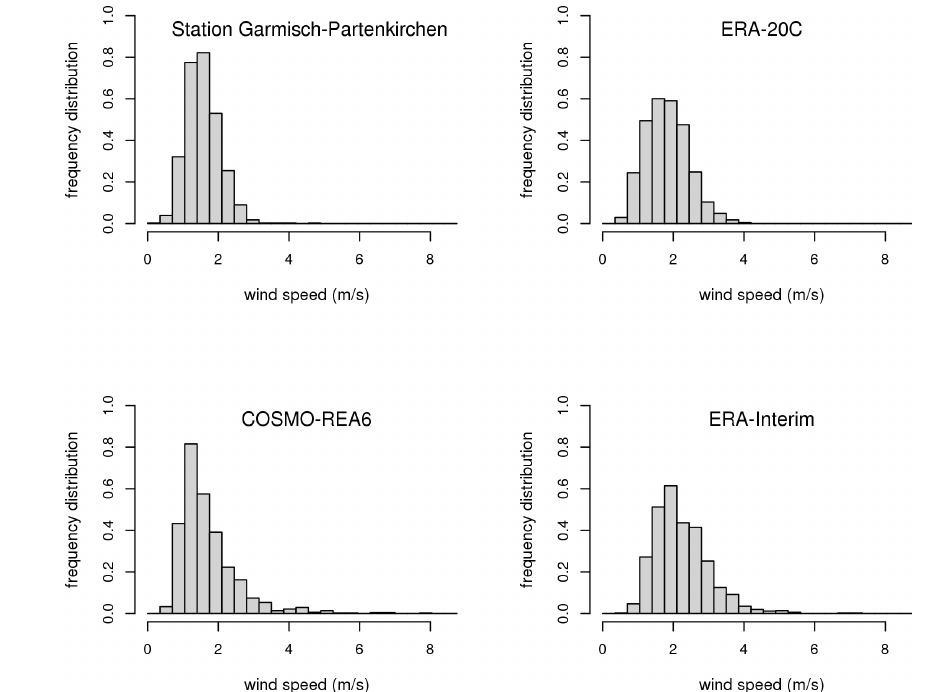
Figure 6. Frequency distribution of daily mean wind speeds in the period 2007 to 2010 for the example station Garmisch-Partenkirchen (top left) and matching grid cells of ERA-20C (top right), COSMO-REA6 (bottom left), and ERA-Interim wind fields (bottom right).